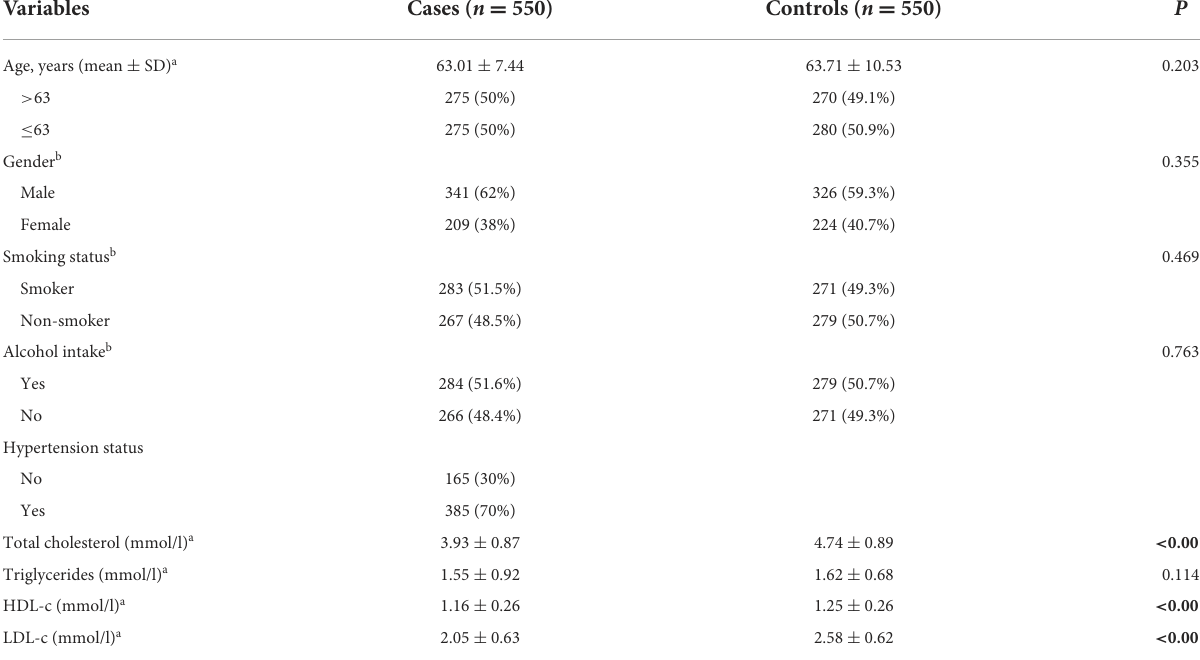
TABLE 1 Basic characteristics of participants in this